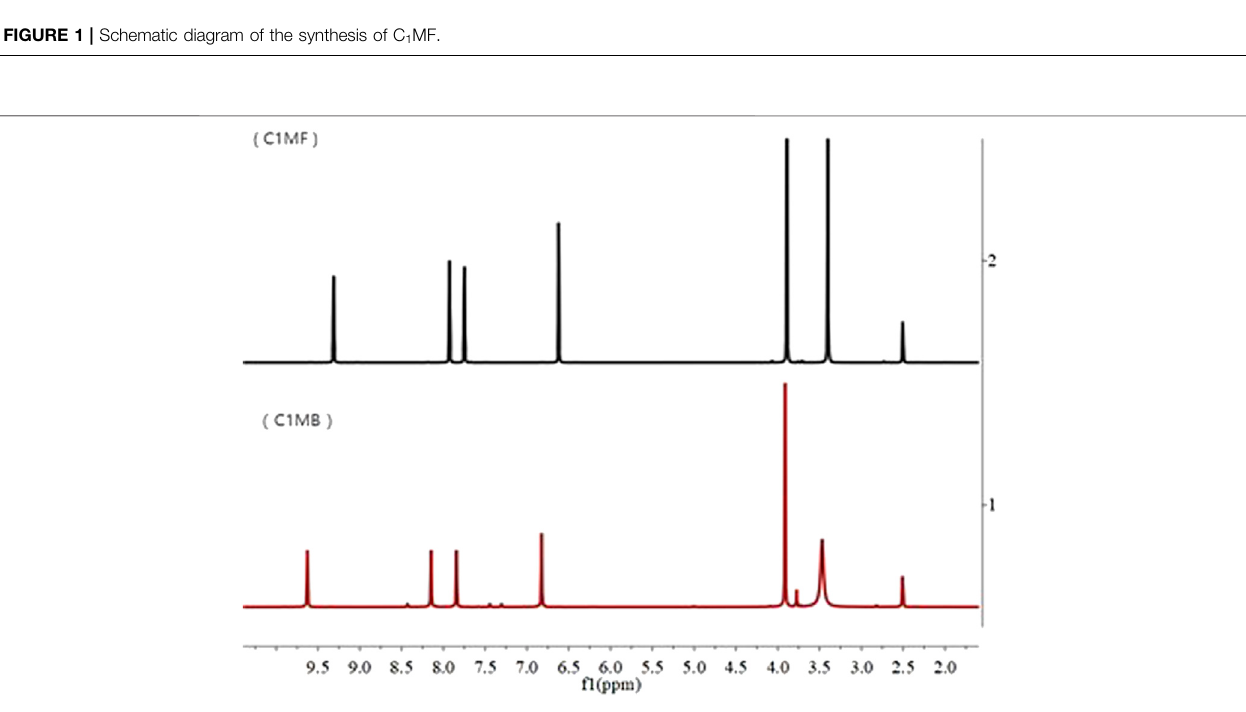
FIGURE 2 | 1 HNMR of the C 1 MB and C 1